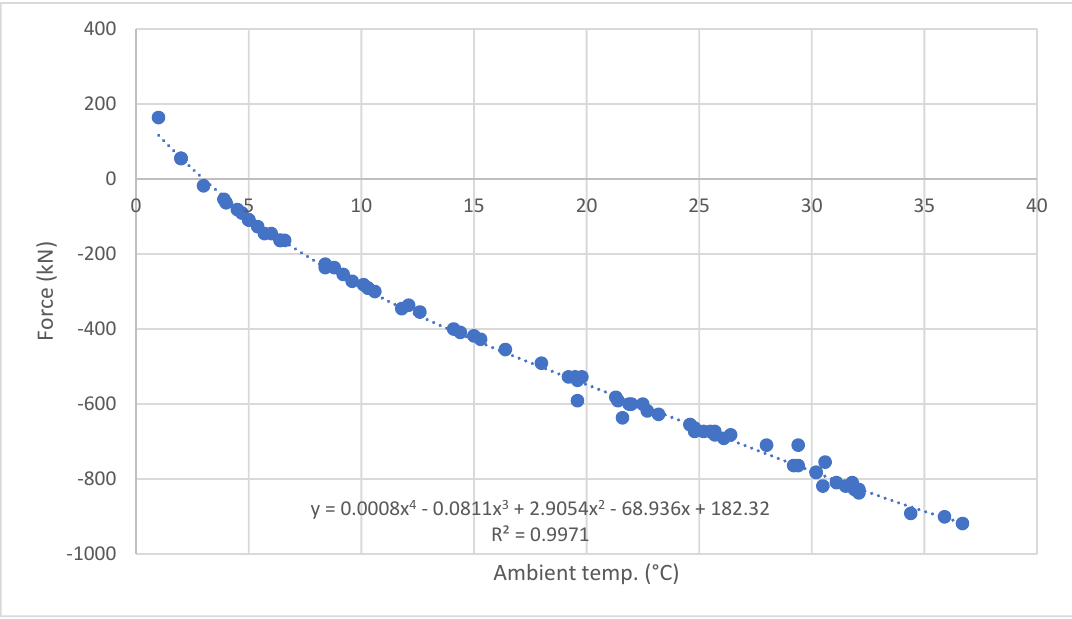
Figure 14. Dependence of the longitudinal force of the rail under load on the ambient temperature (source: own work). Based on the measurements carried out, a dependence was obtained for which the correlation coefficient R 2 reached 0.9971, which should be considered a very good result. The dependence of the longitudinal force of the rail without load f szbo on the ambient temperature t o is presented as formula